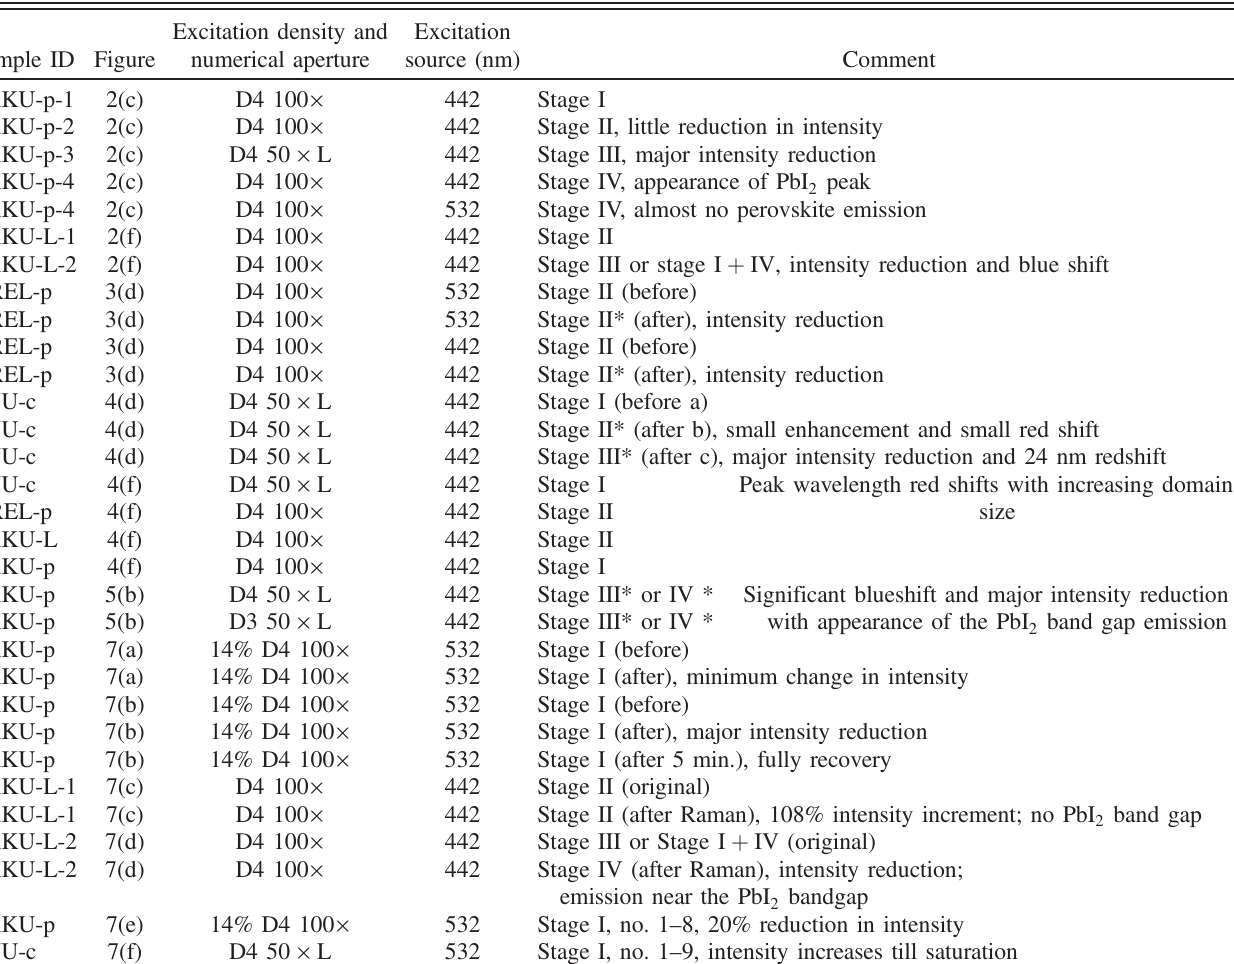
TABLE II. Summary of PL data. All PL spectra are measured under TAT = CT ¼ 1 s = 1 s. The asterisk indicates a light-induced degradation